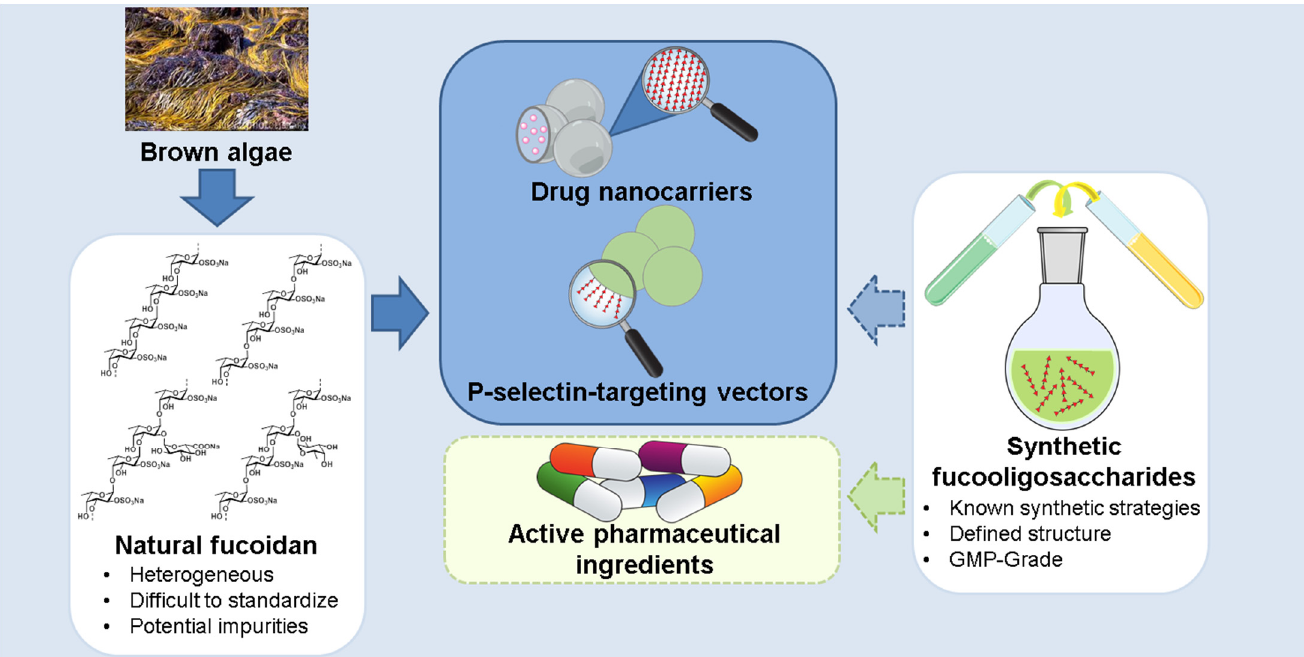
Figure 2. Perspectives and challenges in fucoidan application.